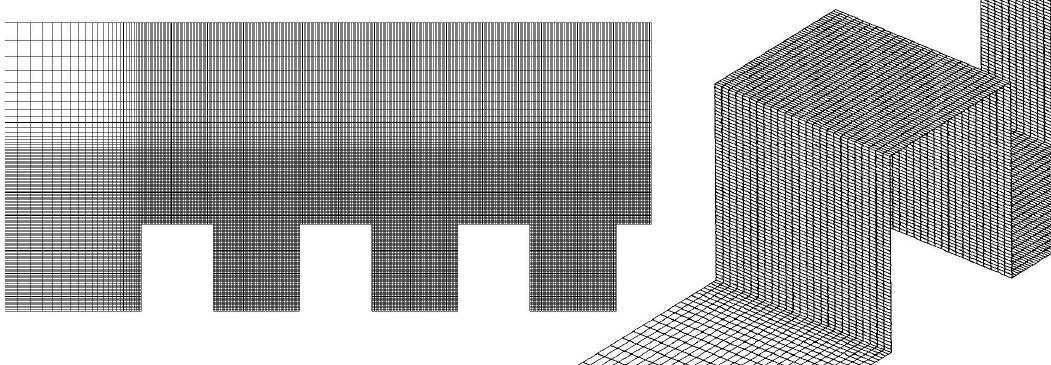
Figure 10. Side view of the central plane (only the first three canyons shown) and 3D view (only the first model block shown) of the Computational Fluid Dynamics